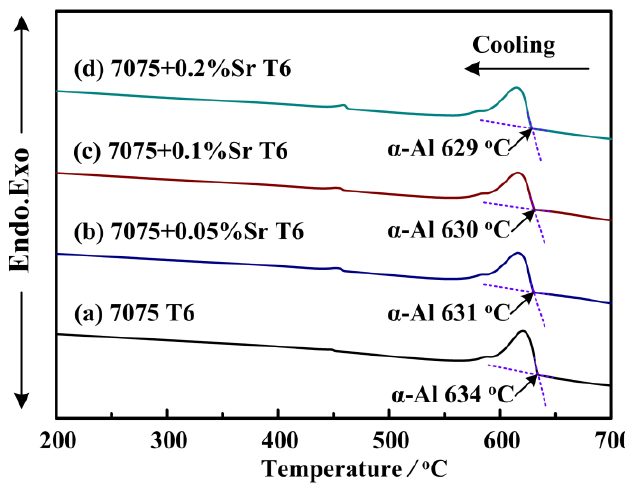
Figure 6. DSC curves for 7075Al T6 heat treated samples with various contents of Sr: ( a ) 0 wt. % ; ( b ) 0.05 wt. % ; ( c ) 0.1 wt. % ; and ( d ) 0.2 wt. % Sr.